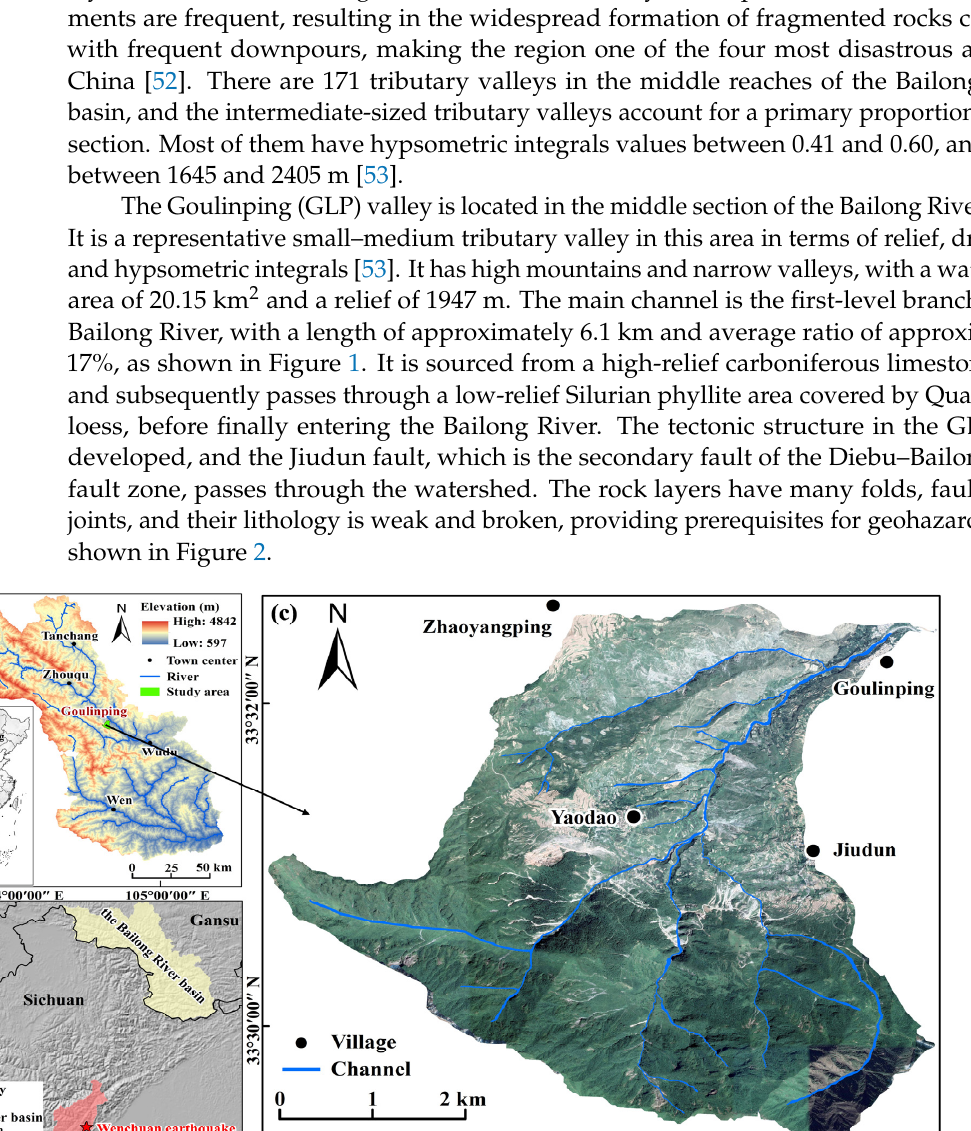
Figure 2. Geomorphic map of the GLP. Climatically, the monsoon strongly influences the study area, which is warm and humid in summer and cold and dry in winter [52]. The annual precipitation of the area is 487.2 mm, 75 to 85% of which falls between May and September [53]. The average annual precipitation varies across the valley, with the largest cumulative precipitation occurring in the upper–middle reaches and decreasing downstream (Figure 3). It should be empha- sized that there have been several extreme rainfall events in recent years, the most serious being in August 2020, with an annual precipitation of nearly 800 mm. In this region, the average precipitation of August in the past 30 years was 59.4 mm, while it quadrupled to 258.9 in August 2020. Climatic conditions have triggered geohazards in the study area.